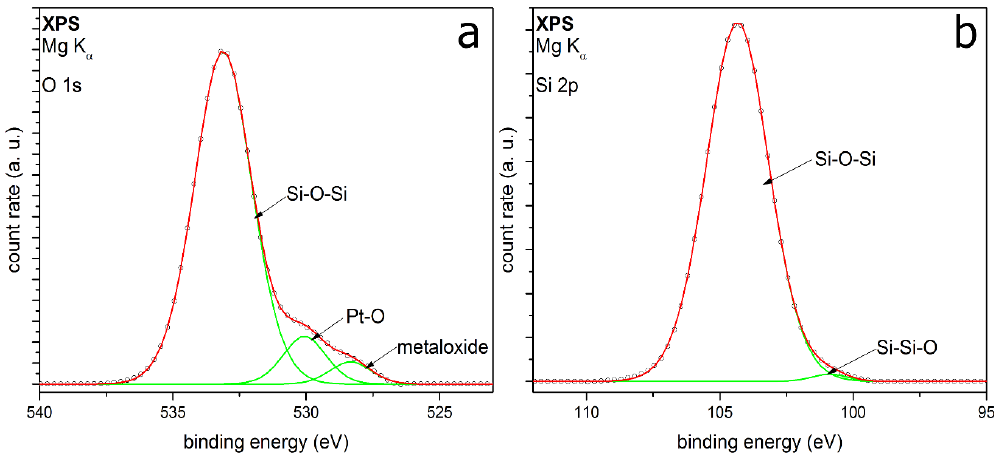
Figure 9. XPS detail spectra O 1s ( a ) and Si 2p ( b ) of coatings on Pt metal particles with HMDSO as the precursor.